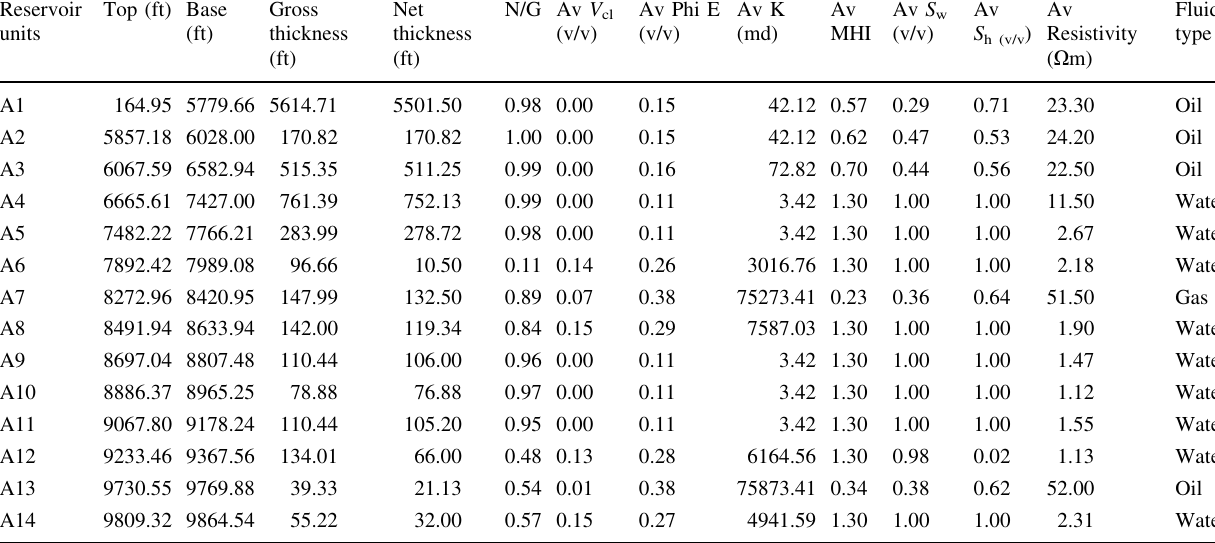
Table 2 Average petrophysical parameters for the reservoirs in JAP-1 well Reservoir